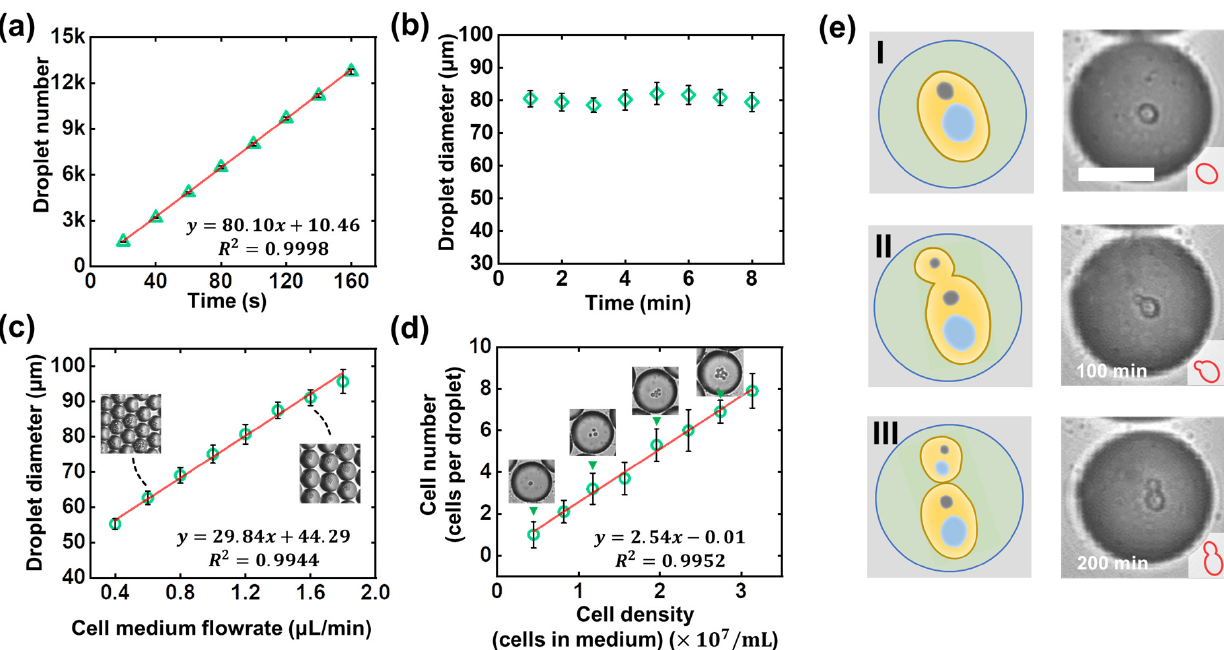
Figure 4. Investigation of the CFSE-based 3D cell culture system. ( a ) Time-dependence of droplet numbers. ( b ) Plot of emulsion droplet diameter as a function of running time, to show the time- stability of the microfluidic CFSE device. The cell medium and oil flow rates were set at 1.28 μ L/min and 0.49 μ L/min. ( c ) Measured diameters of the droplets were plotted against the different cell me- dium flowrate conditions. The inset microscopic images show the droplets with diameters of 62.62 ± 1.95 μ m and 91.09 ± 2.26 μ m, respectively. ( d ) The relationship between cell number per droplet and cell density in the medium. ( e ) Illustration and microscopic images of the proliferation process of saccharomyces cerevisiae cell. I: A saccharomyces cerevisiae cell was encapsulated in a droplet; II: The saccharomyces cerevisiae cell began to bud and proliferate; III: The saccharomyces cerevisiae cell kept proliferating for 200 minutes. Scale bar: 30 μ m.